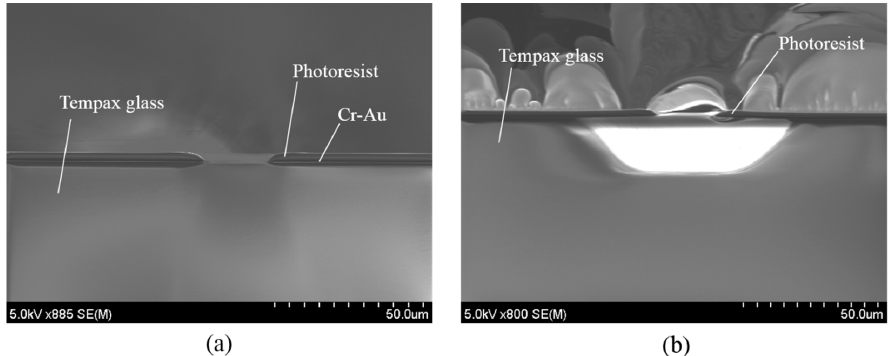
Figure 5. ( a ) Photolithography and metal etching; ( b ) glass etching result.